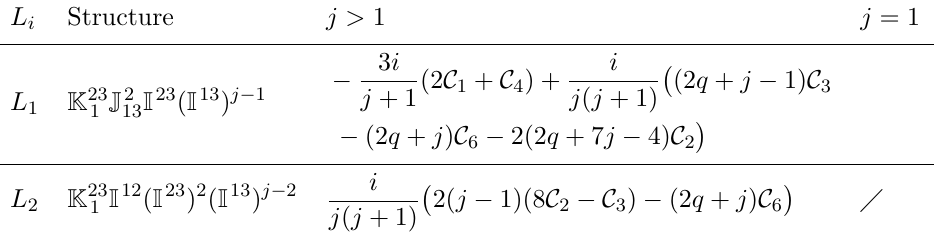
Table 21 . Expansion of the supersymmetric correlator in the component has spin (0 ; 1 ( j + 1)) and QO has spin ( 1 ( j 1) ; 0). The unbarred entry in the j = 1 column can 2 2 (cid:0) be obtained by setting = 0. C 6